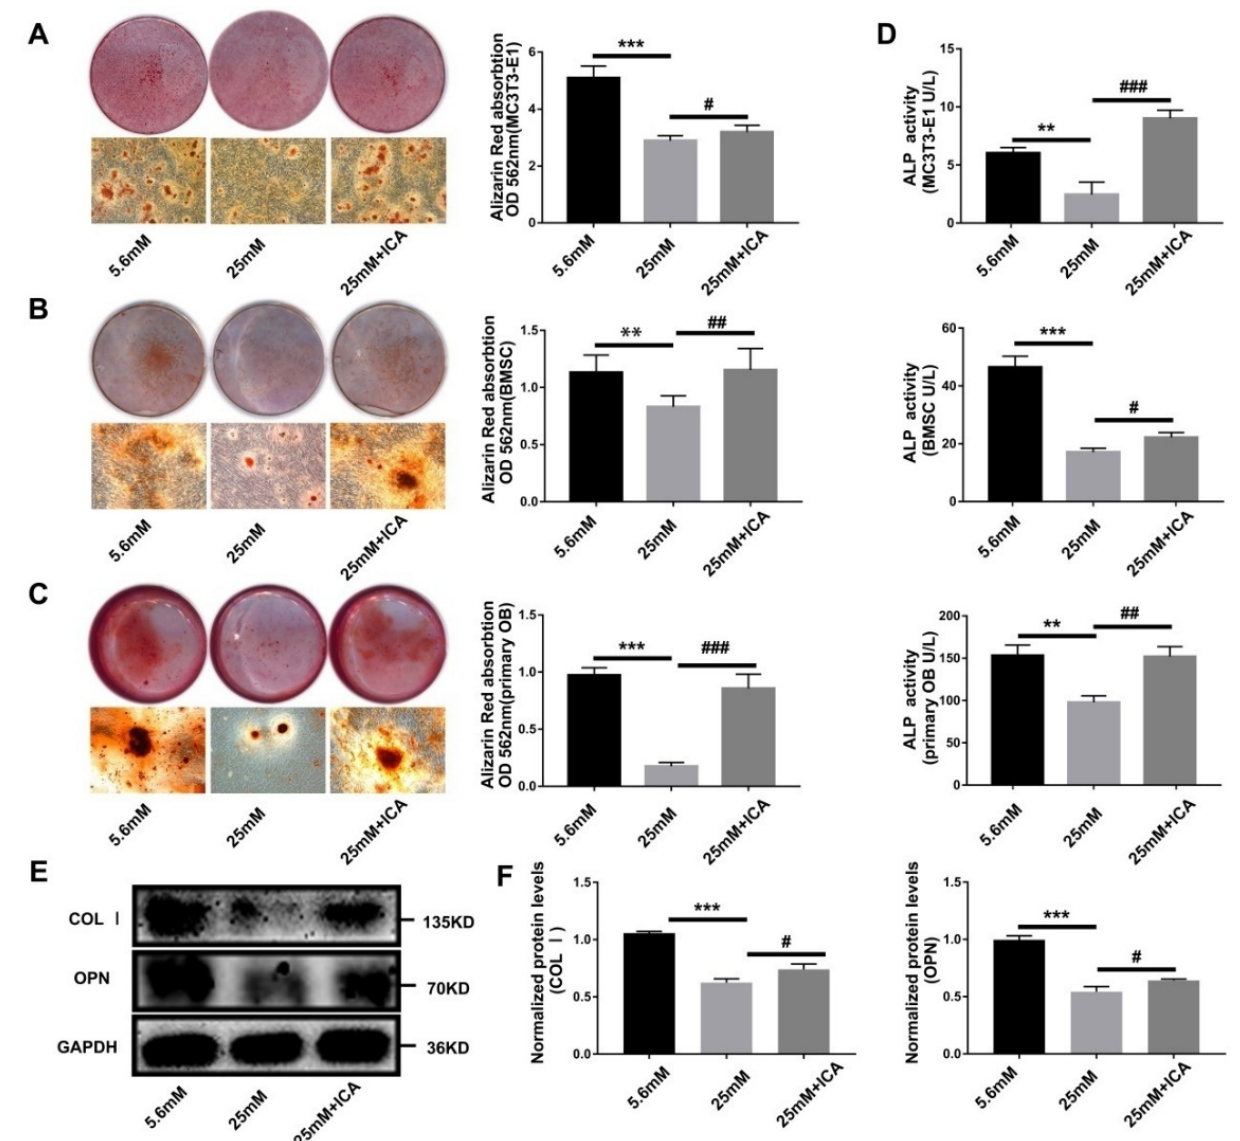
Figure 3. ICA plays a therapeutic role in diabetic bone loss. Three different osteoblast cell lines were induced in for 21 days, and the extracellular matrix mineralized nodules were stained with Alizarin Red. The results of Alizarin red staining and quantitative analysis of MC3T3-E1 ( A ), BMSC ( B ) and primary OB cell ( C ). Three different osteoblast cell lines were induced in different conditions for 3 days, extracted total cell protein to analyze by ELISA kit and western blot. ( D ) ALP activity assay of total cell protein of osteoblasts. ( E ) Western blot analyzed the expression of COL Ⅰ and OPN. ( F ) Quantitative analysis the level of protein expression in ( E ). ** p < 0.01 and *** p < 0.001, compared with 5.6 mM group. # p < 0.05, ## p < 0.01 and ### p < 0.001, compared with 25 mM group.